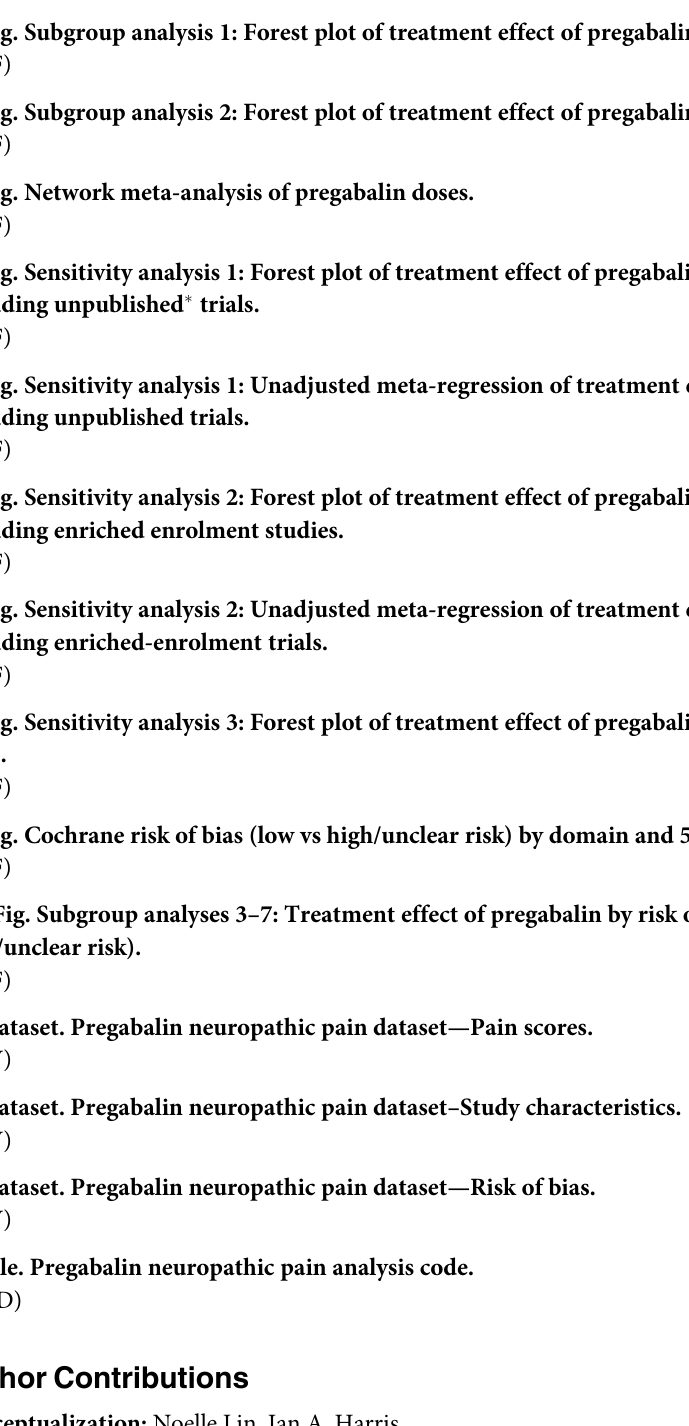
S7 Table. Cochrane risk of bias domains by 5-year period. (PDF) S1 Fig. Subgroup analysis 1: Forest plot of treatment effect of pregabalin by indication. (PDF) S2 Fig. Subgroup analysis 2: Forest plot of treatment effect of pregabalin by dose. (PDF) S3 Fig. Network meta-analysis of pregabalin doses. (PDF) S4 Fig. Sensitivity analysis 1: Forest plot of treatment effect of pregabalin by 5-year period, including unpublished � trials. (PDF) S5 Fig. Sensitivity analysis 1: Unadjusted meta-regression of treatment effect on year, including unpublished trials. (PDF) S6 Fig. Sensitivity analysis 2: Forest plot of treatment effect of pregabalin by 5-year period, including enriched enrolment studies. (PDF) S7 Fig. Sensitivity analysis 2: Unadjusted meta-regression of treatment effect on year, including enriched-enrolment trials. (PDF) S8 Fig. Sensitivity analysis 3: Forest plot of treatment effect of pregabalin by year (in quar- tiles). (PDF) S9 Fig. Cochrane risk of bias (low vs high/unclear risk) by domain and 5-year period. (PDF) S10 Fig. Subgroup analyses 3–7: Treatment effect of pregabalin by risk of bias (low risk vs high/unclear risk). (PDF) (CSV) (CSV) (CSV) S1 File. Pregabalin neuropathic pain analysis